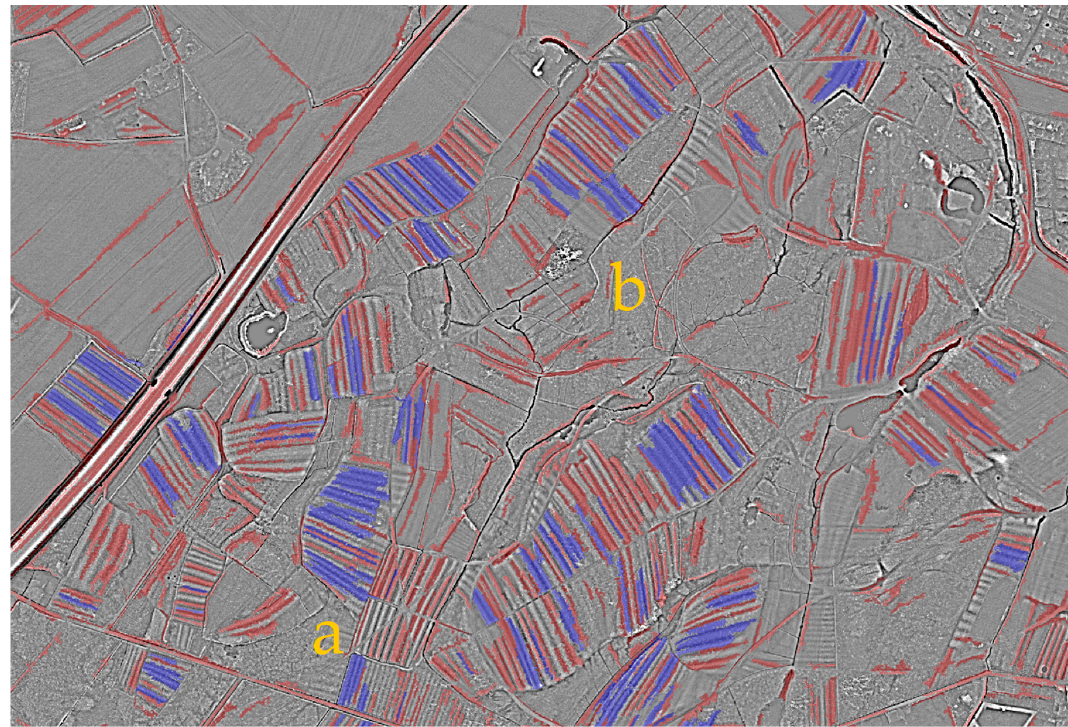
Figure 15. Classification result of the investigation area in Dülmen, overlaying a DM. The blue objects are ridges or furrows that have at least six adjacent objects of the same class and can therefore be addressed as a part of a Ridge and Furrow area. The red structures look like ridges or furrows in terms of shape and are a minimum or maximum, but do not have enough neighbors to be classified in blue [13,16].